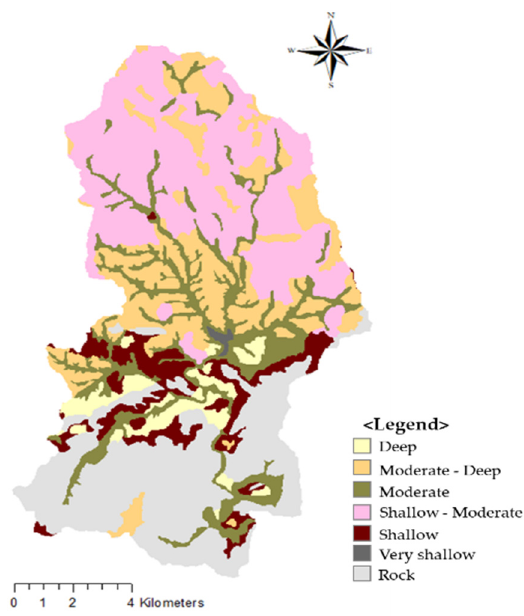
Figure 8. Effective soil depth of the study area.